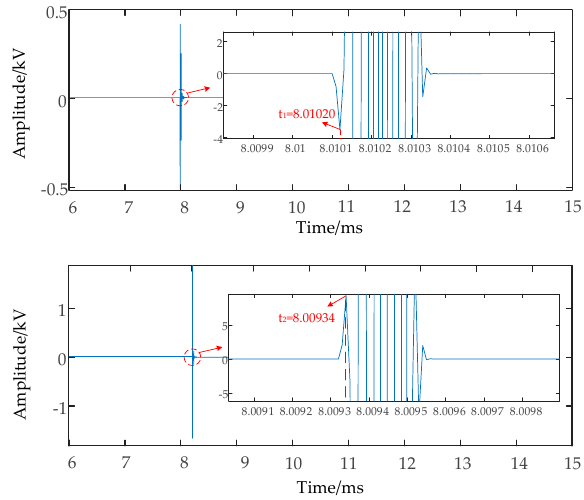
Figure 10. Schematic diagram of the 500 kV transmission line in terms of actual distance.